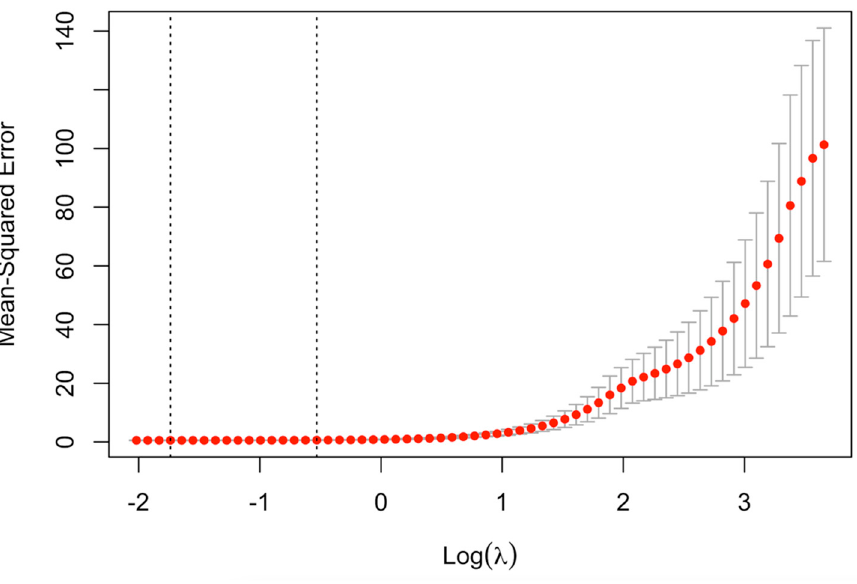
Figure 6. Mean squared errors over parameter 𝜆 in (5) with training data K2.